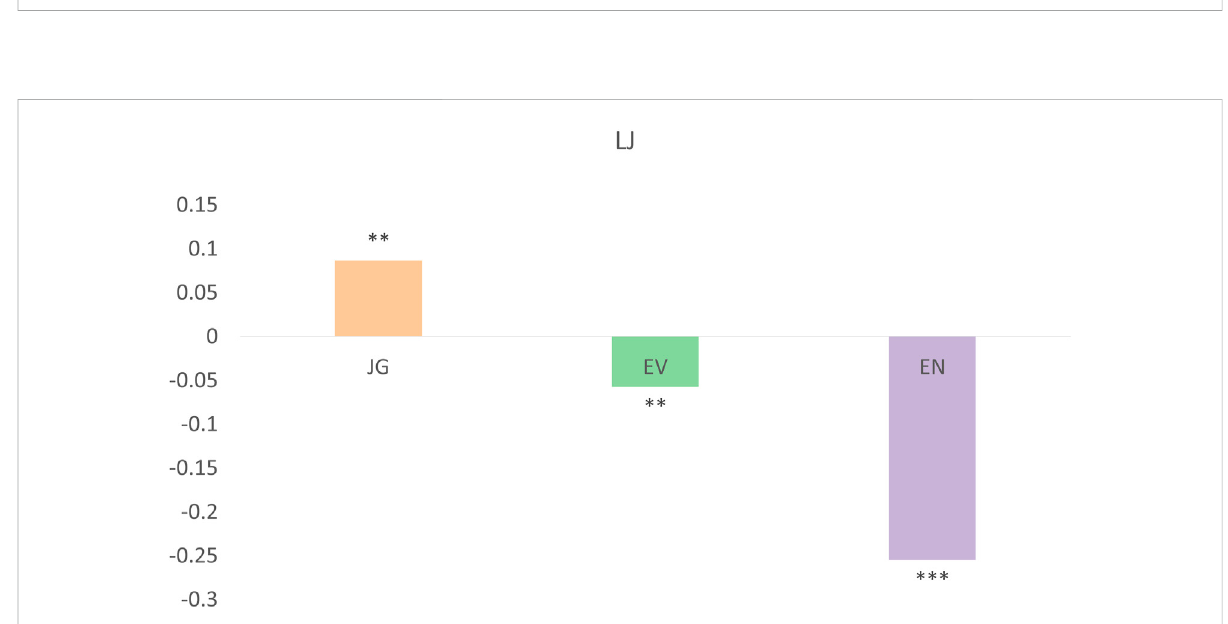
FIGURE 9 Stability test of green fi nance ’ s impacts on high-quality economic development, environmental pollution, and energy consumption (see Supplementary Table S8 for detailed results). *, **, and *** mean signi fi cance at the signi fi cance level of 10%, 5%, and 1%,